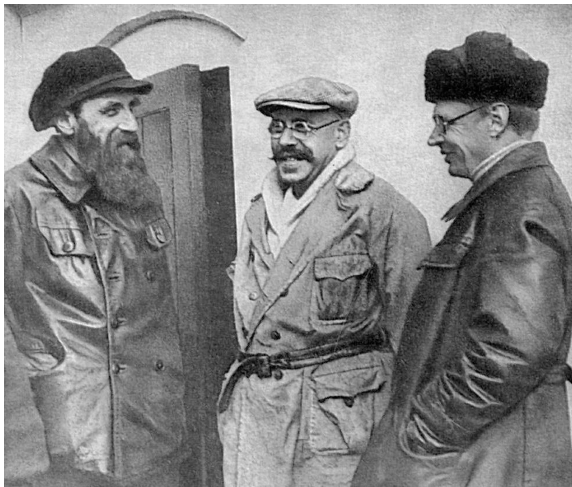
Figure 2. The heads of Soviet Arctic research (left to right): Otto Yu. Schmidt (1891–1956), Rudolf L. Samoylovich (1881– 1939), and Vladimir Yu. Wiese (1886–1954) (http://ngc.gcras.ru/ history.html, last access: 11 August